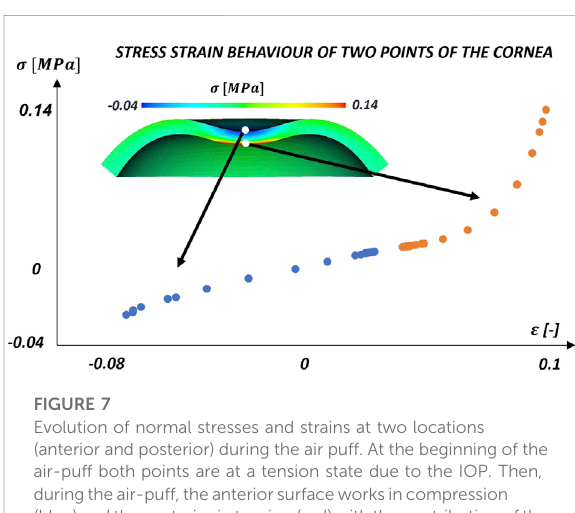
TABLE 5 Analysis of variance (ANOVA) results on the peak distance biomarker. Degrees of freedom (DF) and Effect